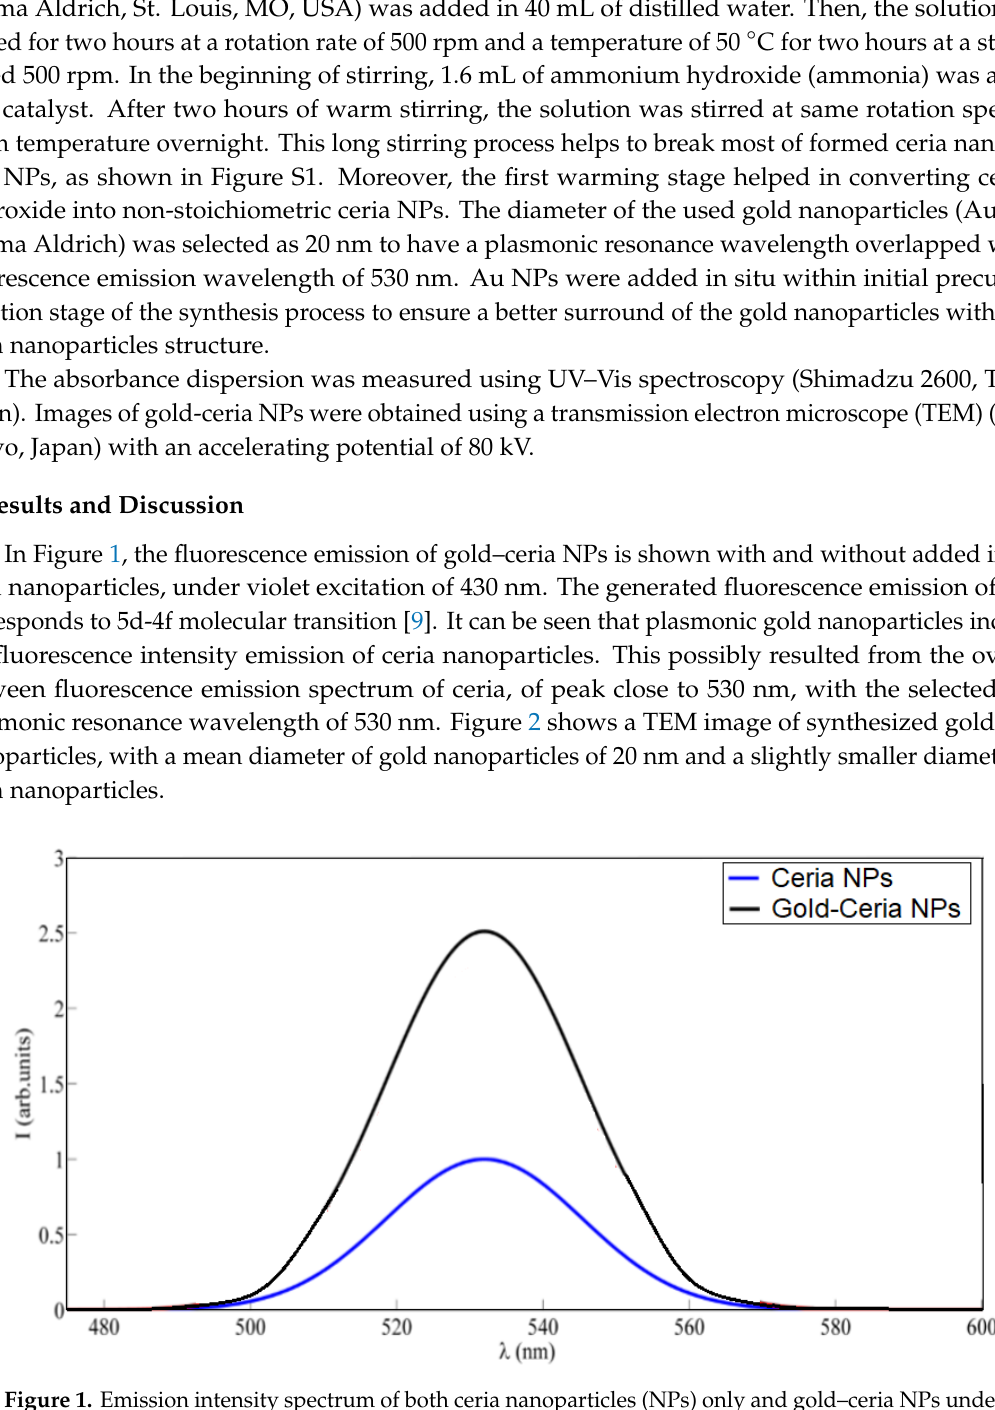
Figure 1. Emission intensity spectrum of both ceria nanoparticles (NPs) only and gold–ceria NPs under 430 nm excitation.